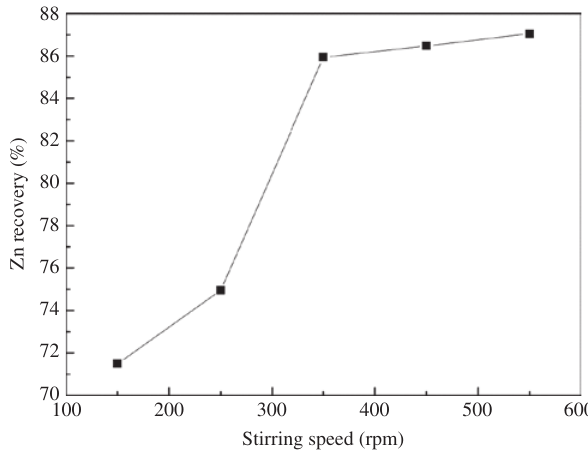
Figure 9: Effect of different stirring speeds on leaching rate of zinc.